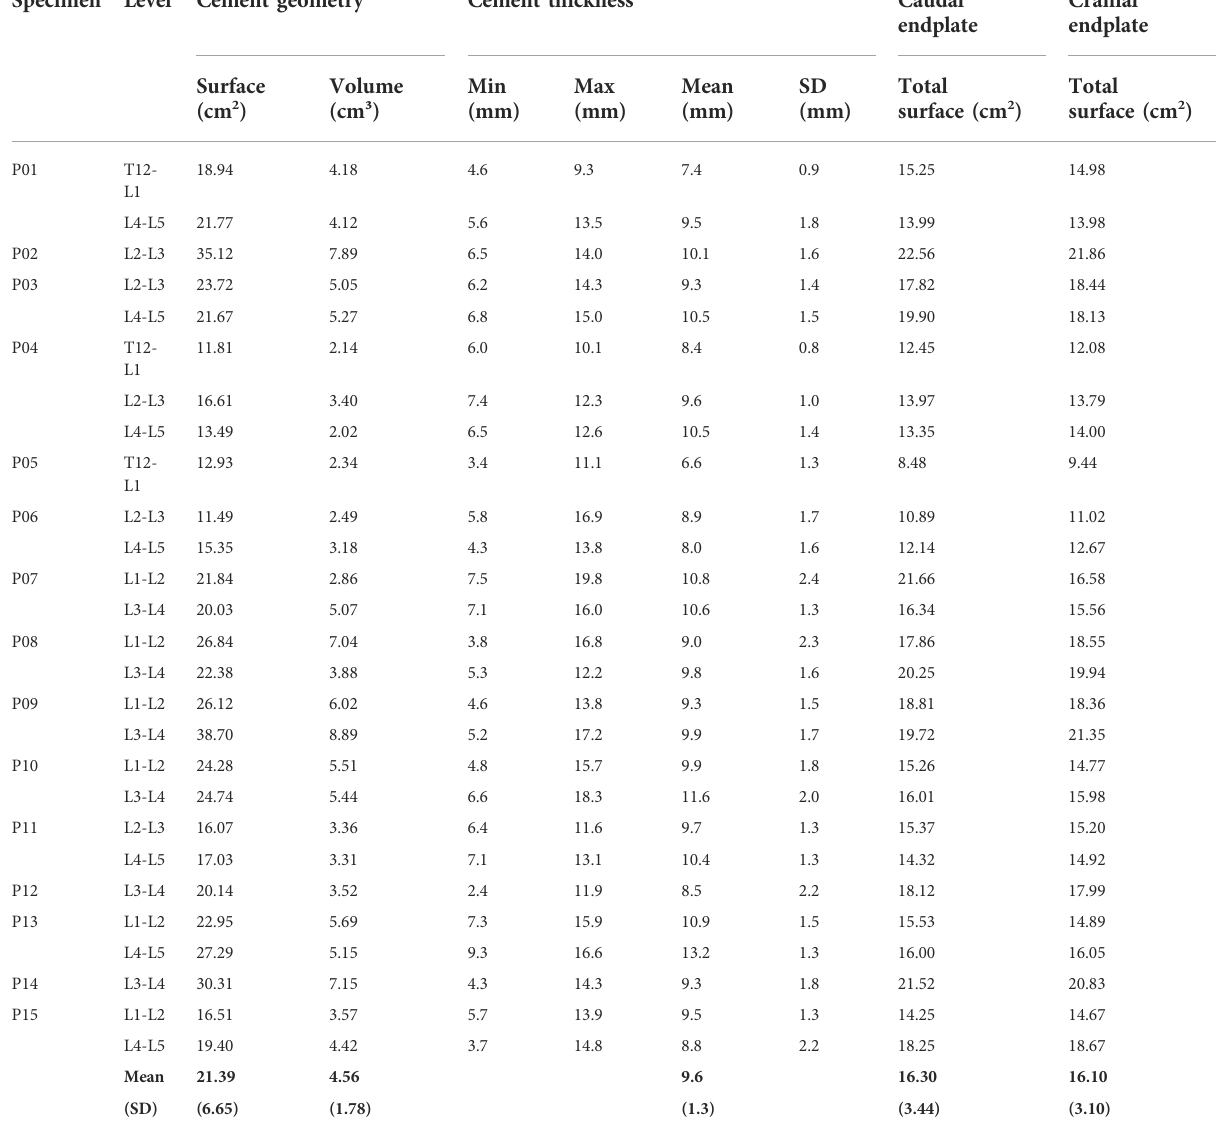
TABLE 3 Summary of the cement distribution analysis for each specimen. The cement thickness between the endplates was measured axially. Specimen Level Cement geometry